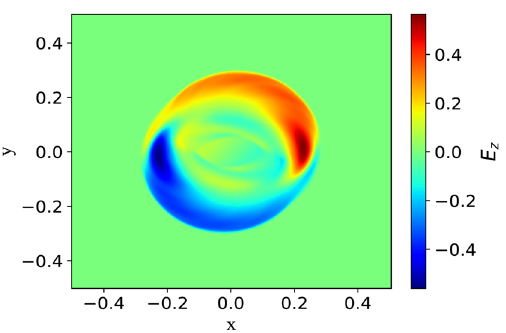
Fig. 11 The electric field component E z at t = 0 . 3 is shown in the 2D resistive rotor test in the Cartesian coordinates